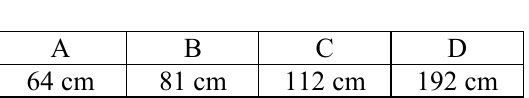
A figure consists of 6 equal squares. The area of the whole figure is 384 cm 2 . Find the perimeter of the